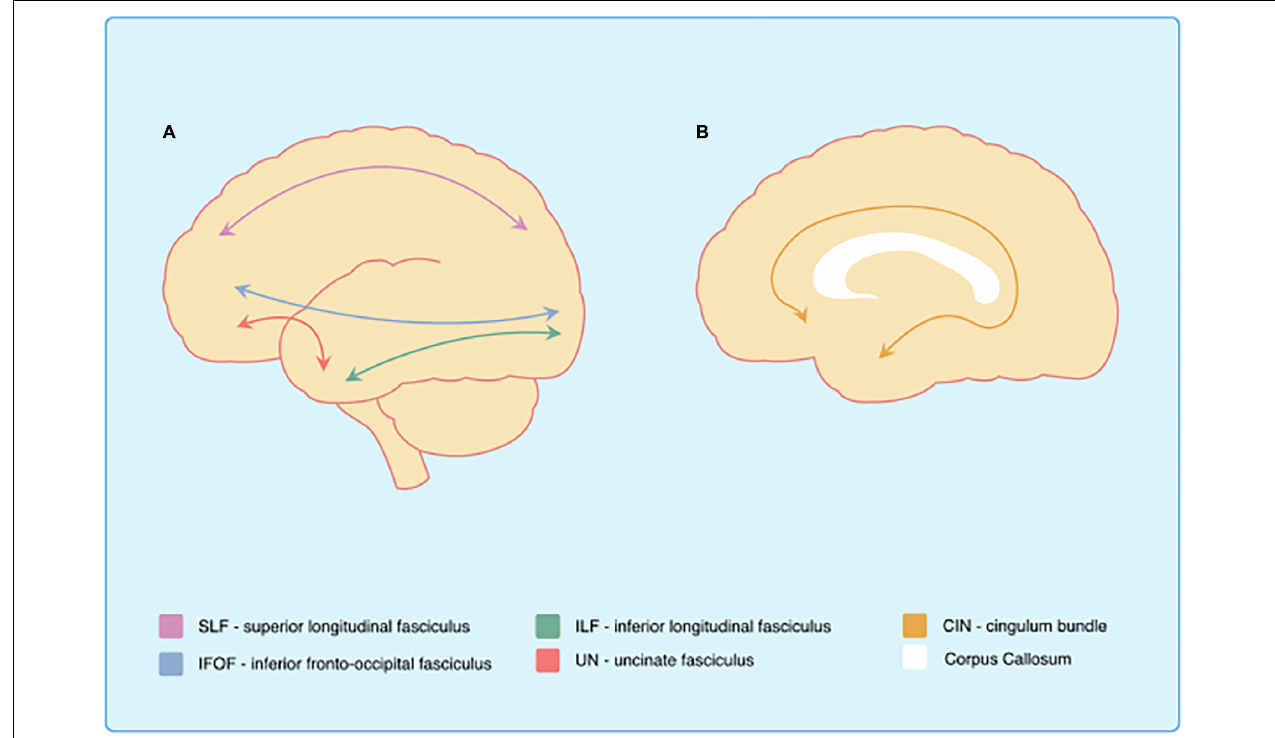
FIGURE 1 | White matter tracts affected in Down syndrome. Schematic representation of the main white matter structures affected in Down syndrome. Al Sagittal view of the brain. Bl Midsagittal view of the brain.